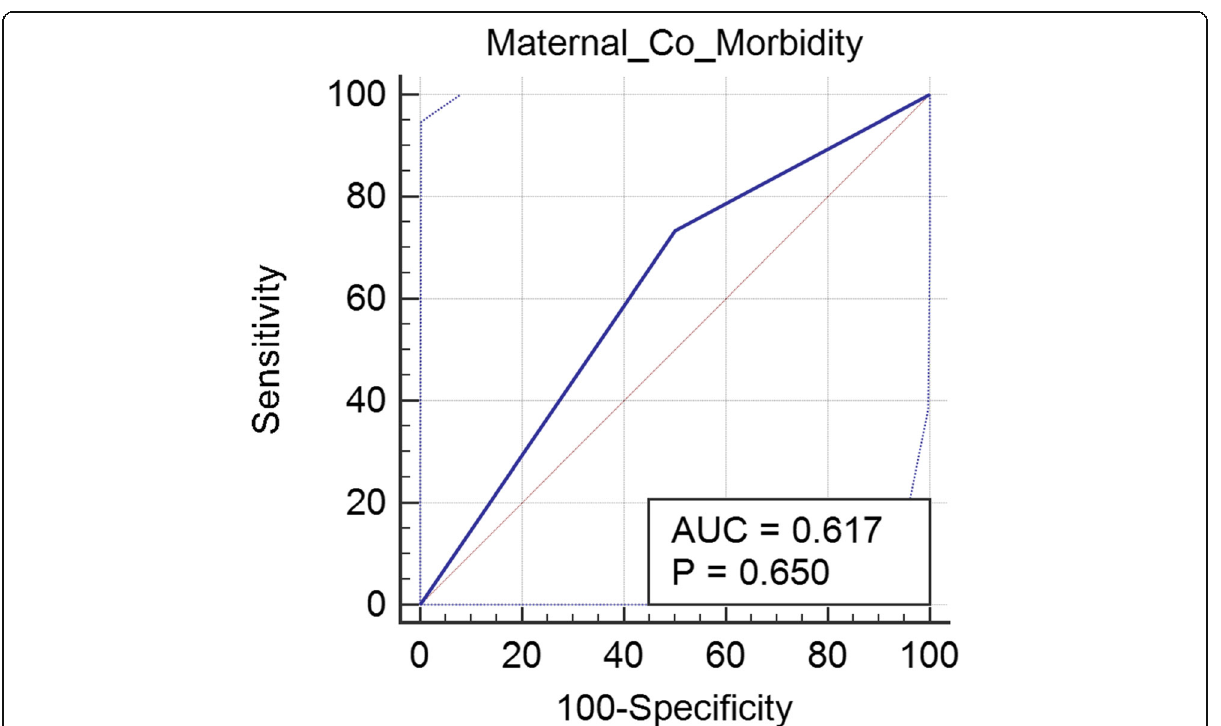
Fig. 2 ROC curve showing the relationship between maternal co-morbidities and placental vascular compromise. Abbreviations: AUC: area under